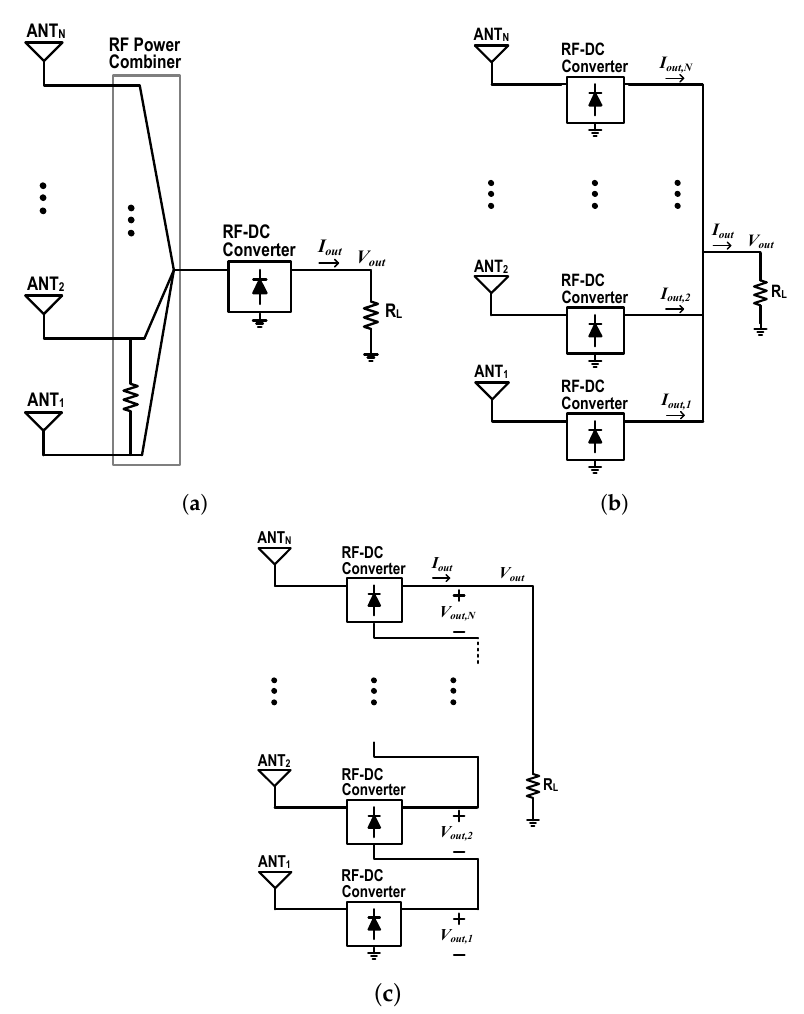
Figure 2. Power-combining methods for rectenna array, ( a ) RF power-combining; ( b ) DC current-combining; and ( c ) DC